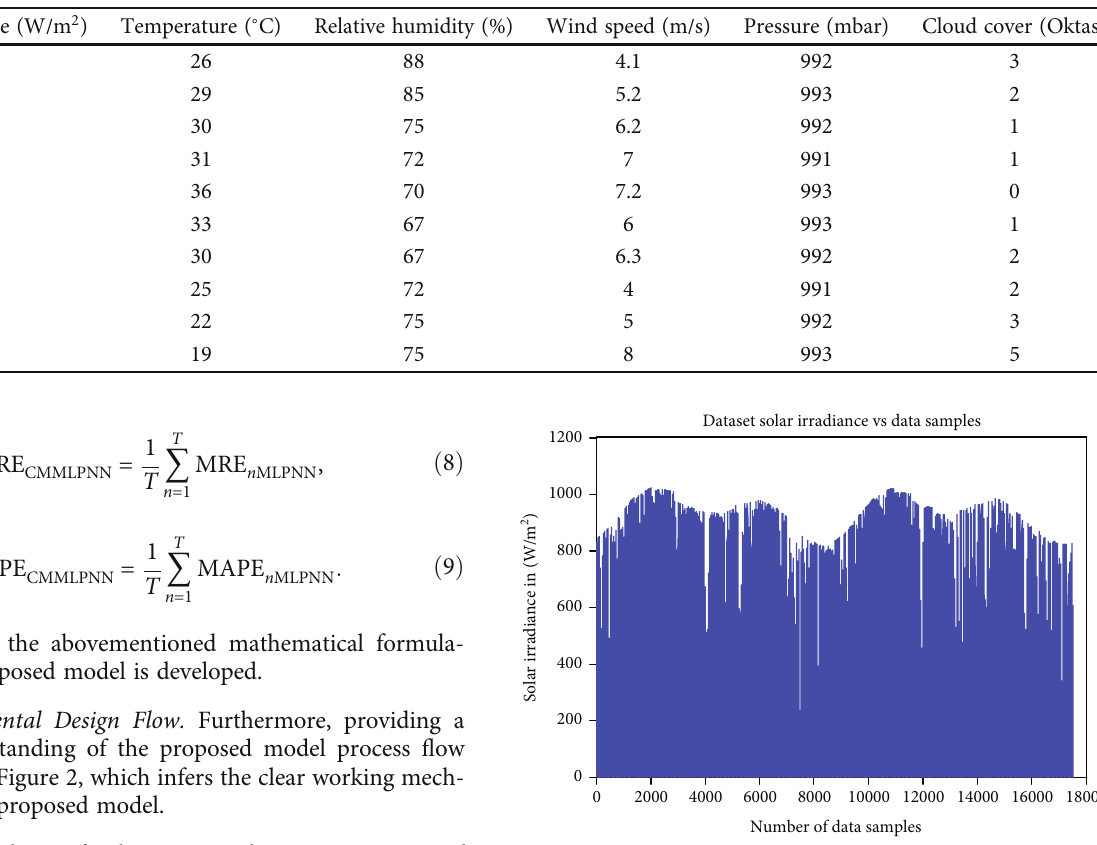
Table 2: Acquired real-time input data samples.